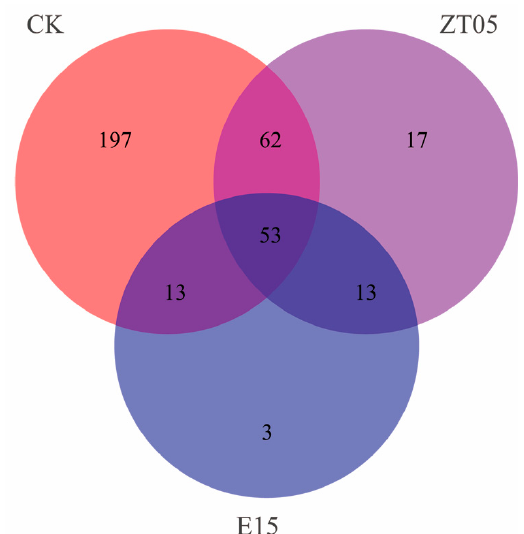
Figure 3. Venn diagram showing the shared operational taxonomic units (OTUs) of CK, ZT05, E15 treatments. CK: inoculation with PD blank culture medium. ZT05: single inoculation with T. virens ZT05. E15: single inoculation with T. harzianum E15.